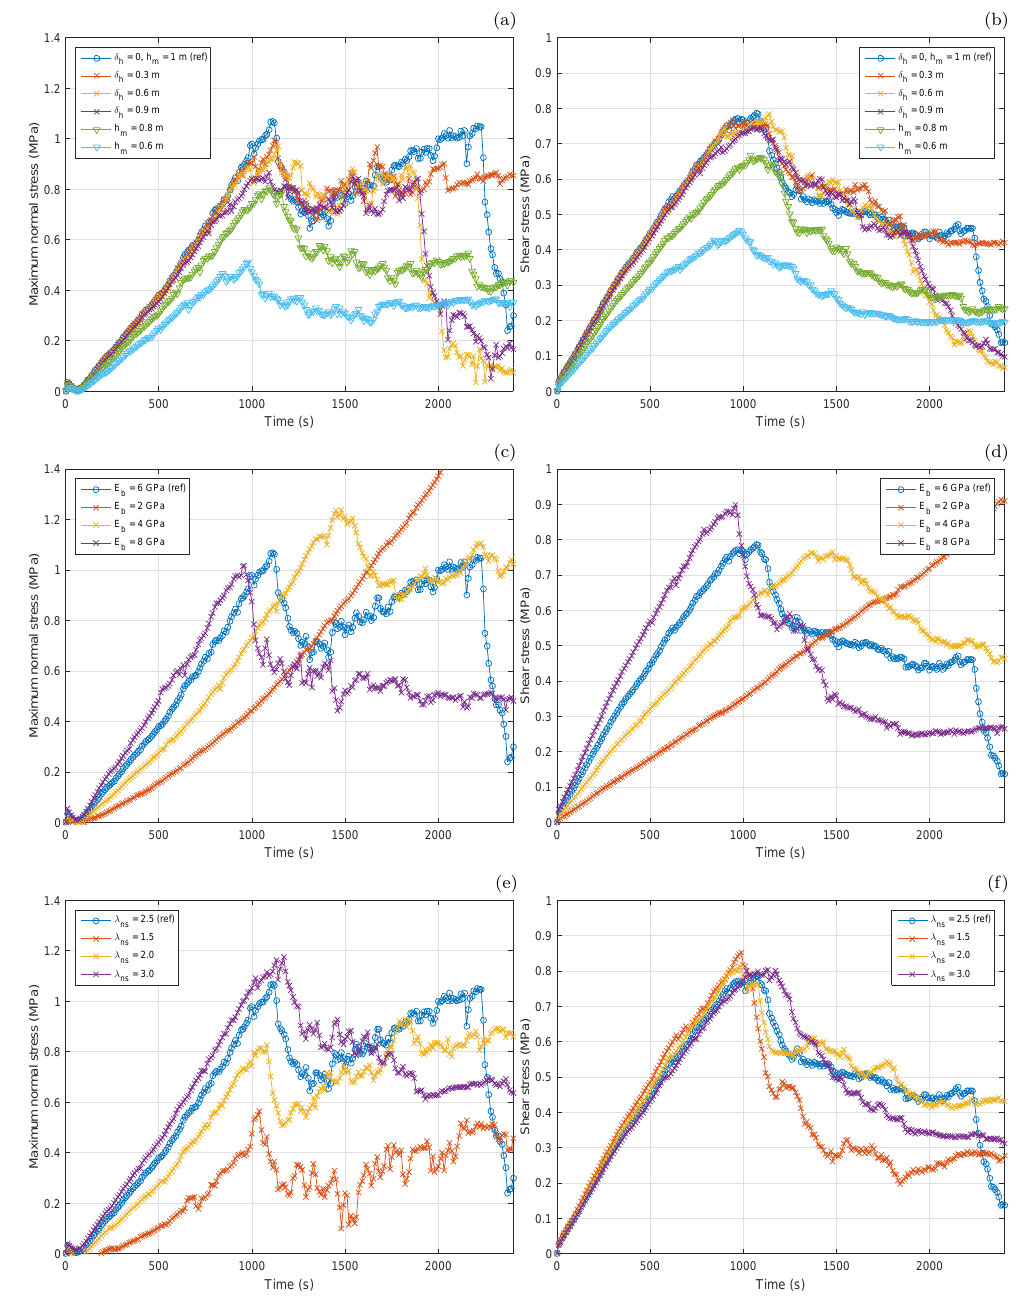
Figure 7. As in Fig. 6 but in simulations under shear strain.